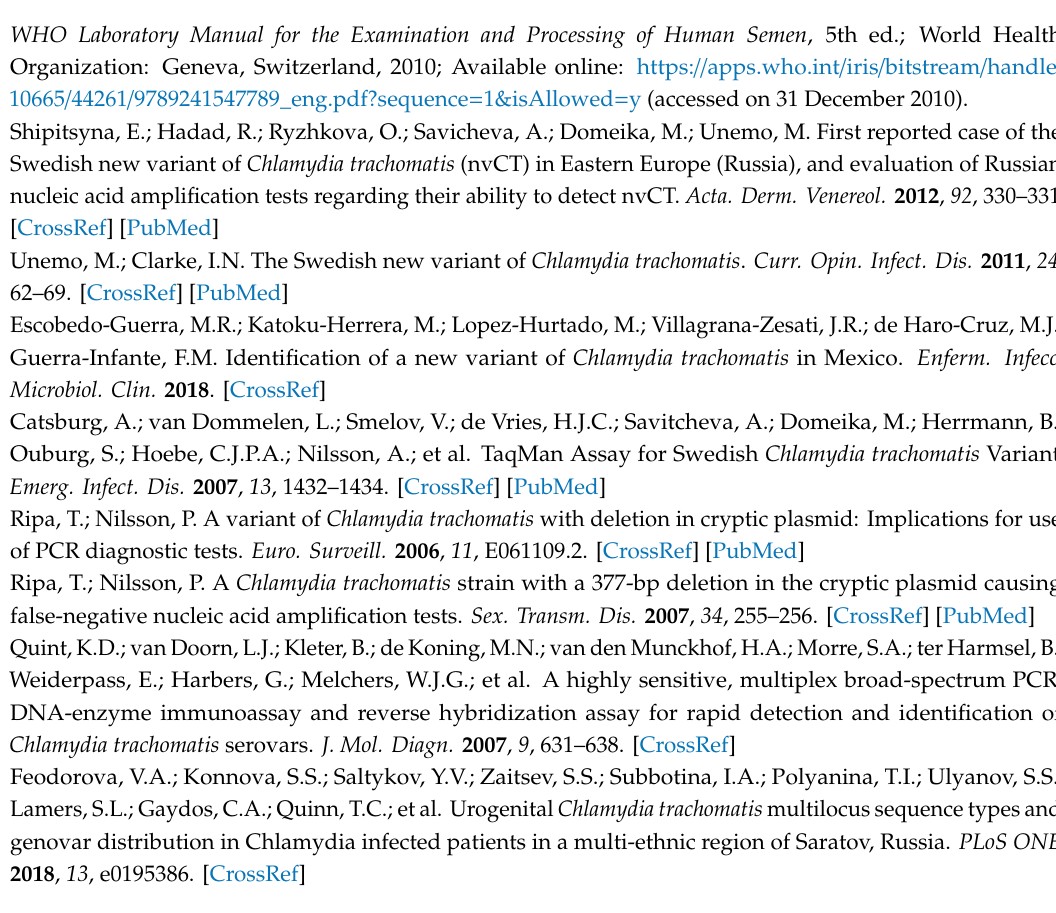
Table S1: The main sperm characteristics of the case-patient, Saratov city,